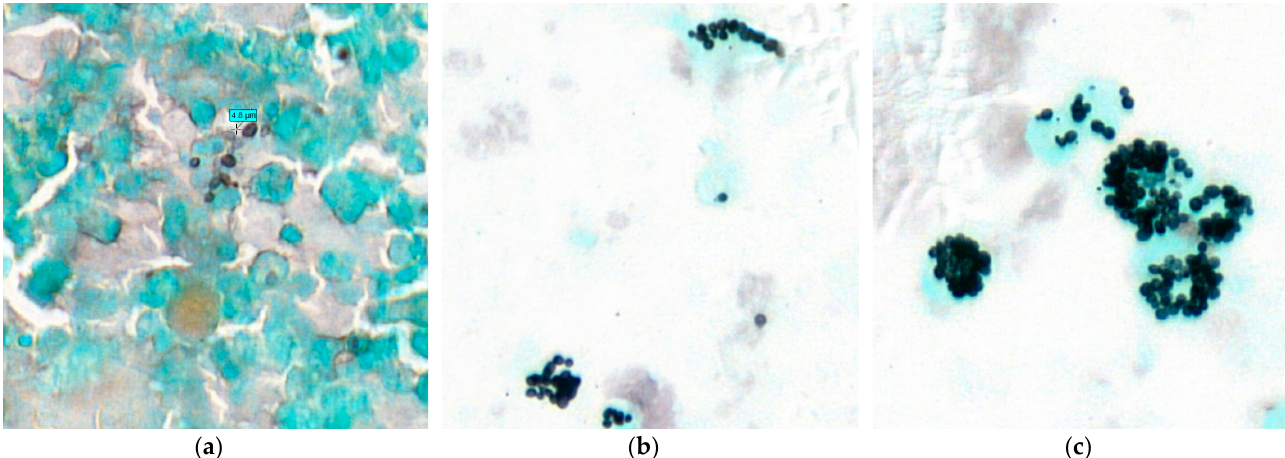
Figure 3. Clustering pattern of Histoplasma capsulatum yeasts in the bronchoalveolar lavage. We could identify three clus- tering patterns. Type I: isolated yeasts and/or small clusters or small chains of <5 yeasts ( a ) Gomori-Grocott stain at ×60. Type II: type I + clusters or chains of >5 yeasts, ( b ) Gomori-Grocott stain at ×40. Type III: type II + rosettes structures. The rosettes pattern corresponds to round structures made of one or more layers of yeasts (often > 10 yeasts) leaving a pseudo- cavity in the center ( c ) Gomori-Grocott stain at ×60. Table 1. Data from the 17 patients (14 HIV and 3 non-HIV) with pulmonary histoplasmosis. The characteristics of their BALs (cellularity and cell formula) and the Histoplasma capsulatum yeasts detected by the Gomori-Grocott stain at a ×40 field (hot spot). HC: Histoplasma capsulatum. IC: intracellular; EC: extracellular. Cluster’s pattern: type I: small cluster or chain < 5 yeasts; type II: I + cluster or chain > 5 yeasts; type III: II + rosette.